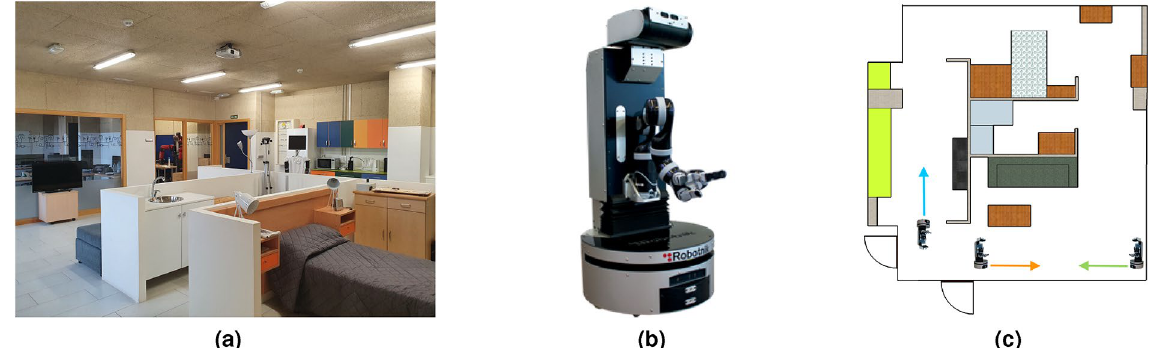
Figure 1. ( a ) Leon@Home Testbed. ( b ) Orbi-One Robot. ( c ) Leon@Home Testbed schema. The robot icons on the map point out the robot’s location and orientation during the experiments; the arrows show the trajectory of